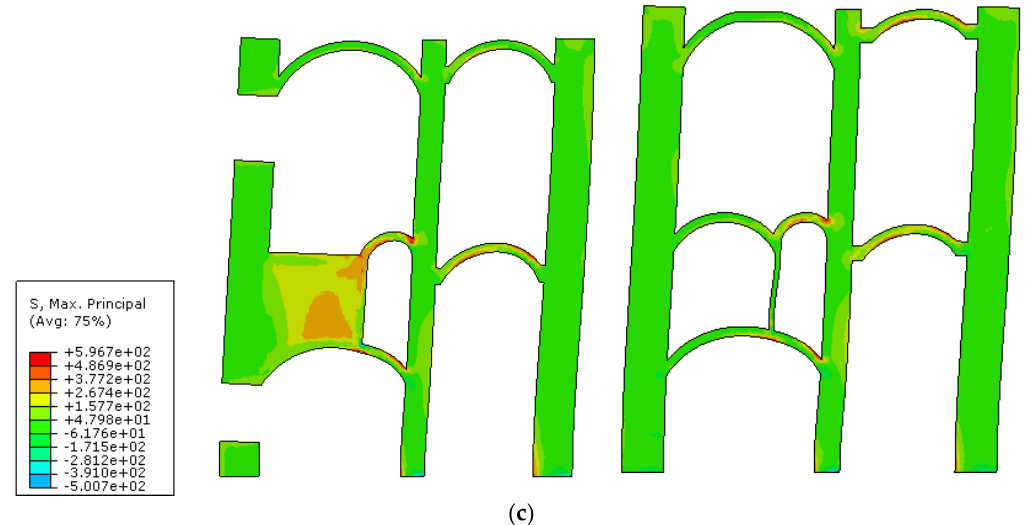
Figure 14. Plot extracted from the FEM. Stress gradient in relation respectively to the cross-sections A-A ’ and B-B ’ placed as in Figures 3 and 4: ( a ) dead weight; ( b ) outwards seismic action; ( c ) inwards seismic action. The stresses are between 5.9 × 10 2 and – 5 × 10 2 (kPa).